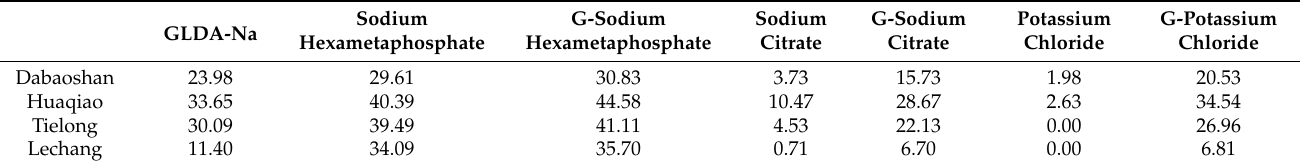
Table 4. Leaching removal rate of Pb in the soil after the combination of GLDA-Na and different salts (%).